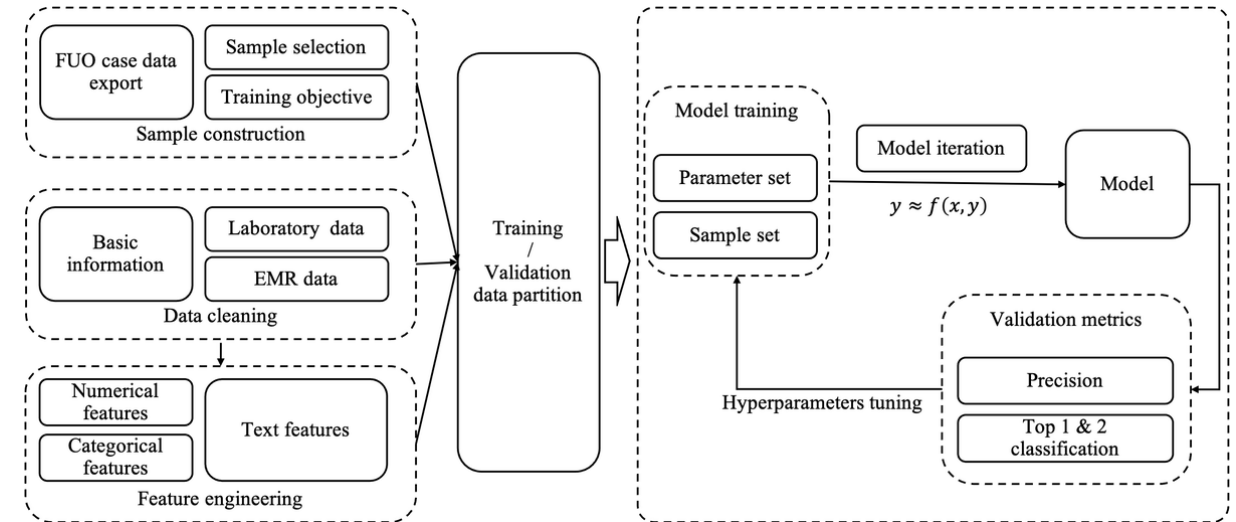
Figure 1. Structure of the fever of unknown origin (FUO) intelligent diagnosis (FID) model. The left side shows the sample construction, data cleaning, and feature engineering process; the right side shows the model training and tuning processes. EMR: electronic medical